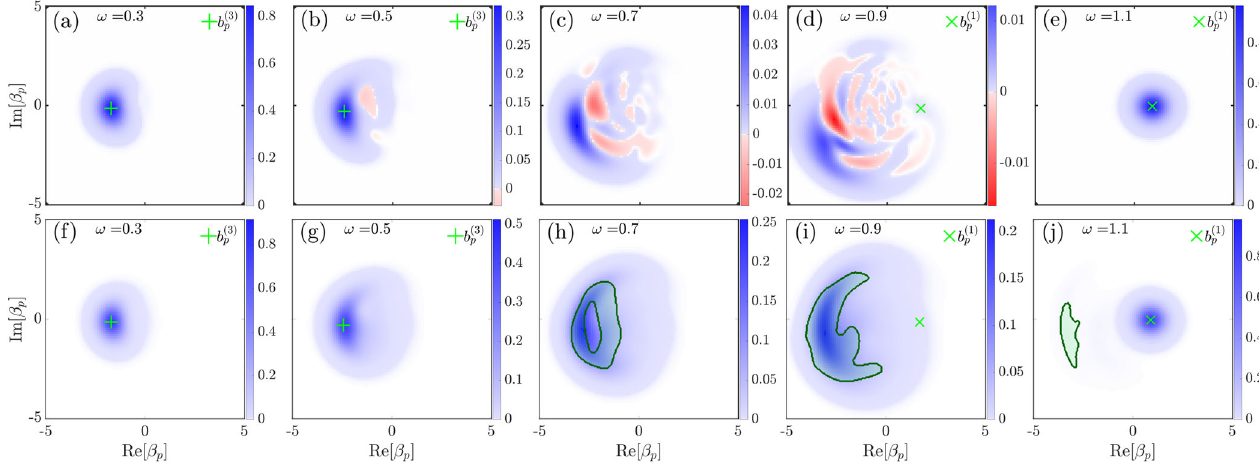
Fig. 4 Wigner functions in the presence of a strange attractor. The Wigner functions for frequencies below and within the strange attractor regime are presented for time t m = 2000/ J . Panels a – e display the Wigner functions on a cut depicting the resonant ( β p ) plane. Panels f – j display the Wigner function for the reduced density matrix associated with the same plane. The classical attractor is superimposed in green. The different fi xed points are displayed using green markers. Here u = 0.1, γ = 0.05, and d =